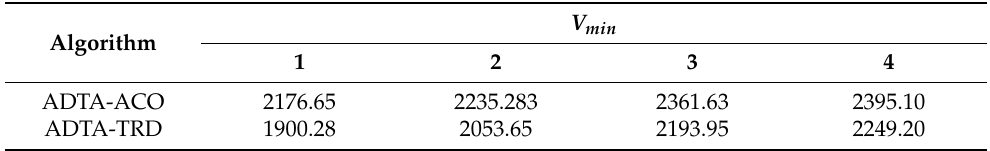
Table 4. The influence of minimal speed of the USV on voyage